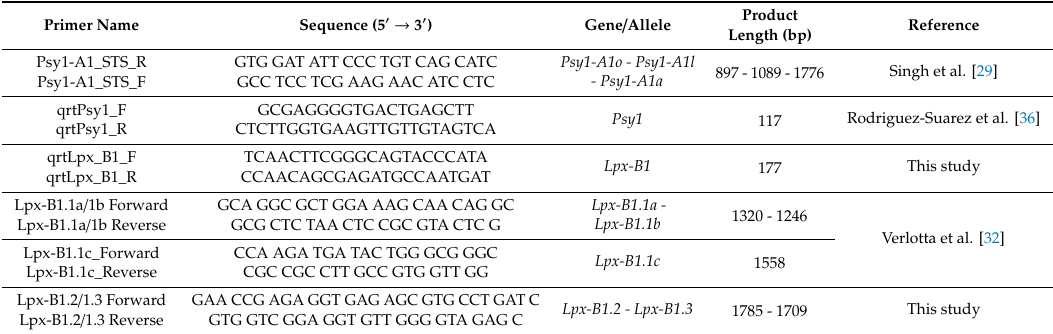
Table 5. List of primers used to genotype the Mediterranean panel for Psy1-A1 and Lpx-B1 .